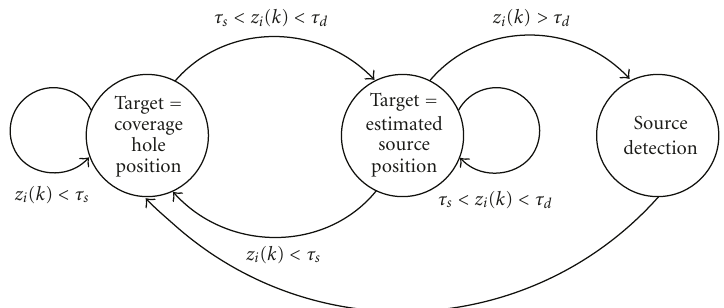
Figure 3: The target allocation strategy for the i th mobile sensor node during the k th step.